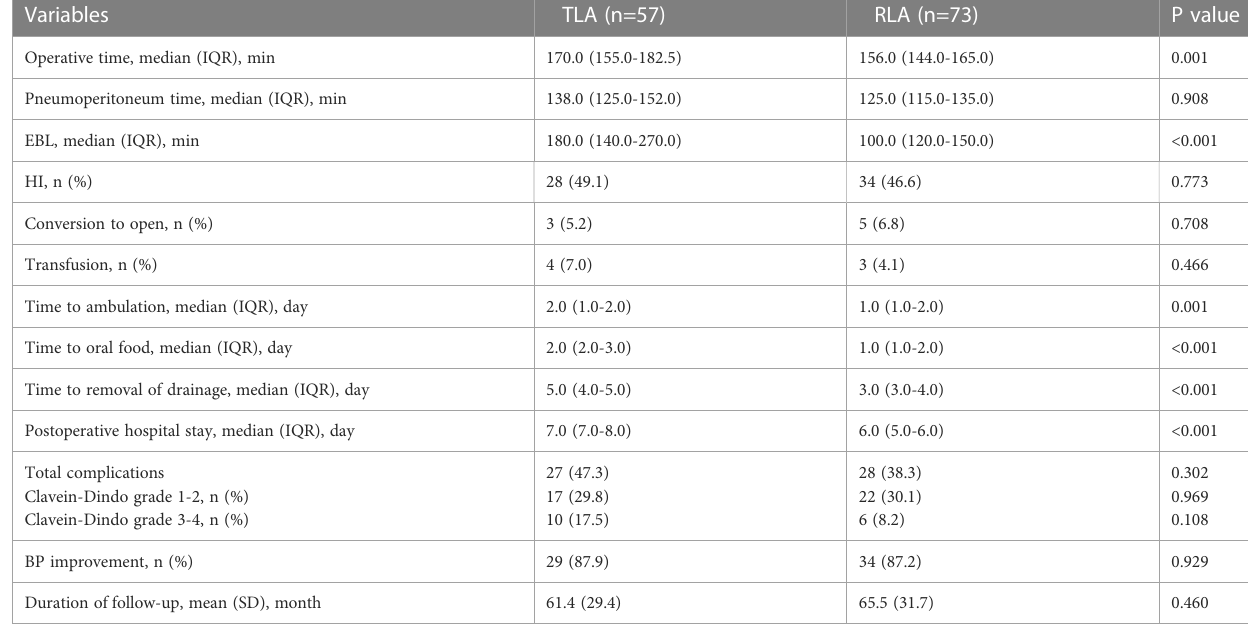
TABLE 2 Perioperative outcomes.